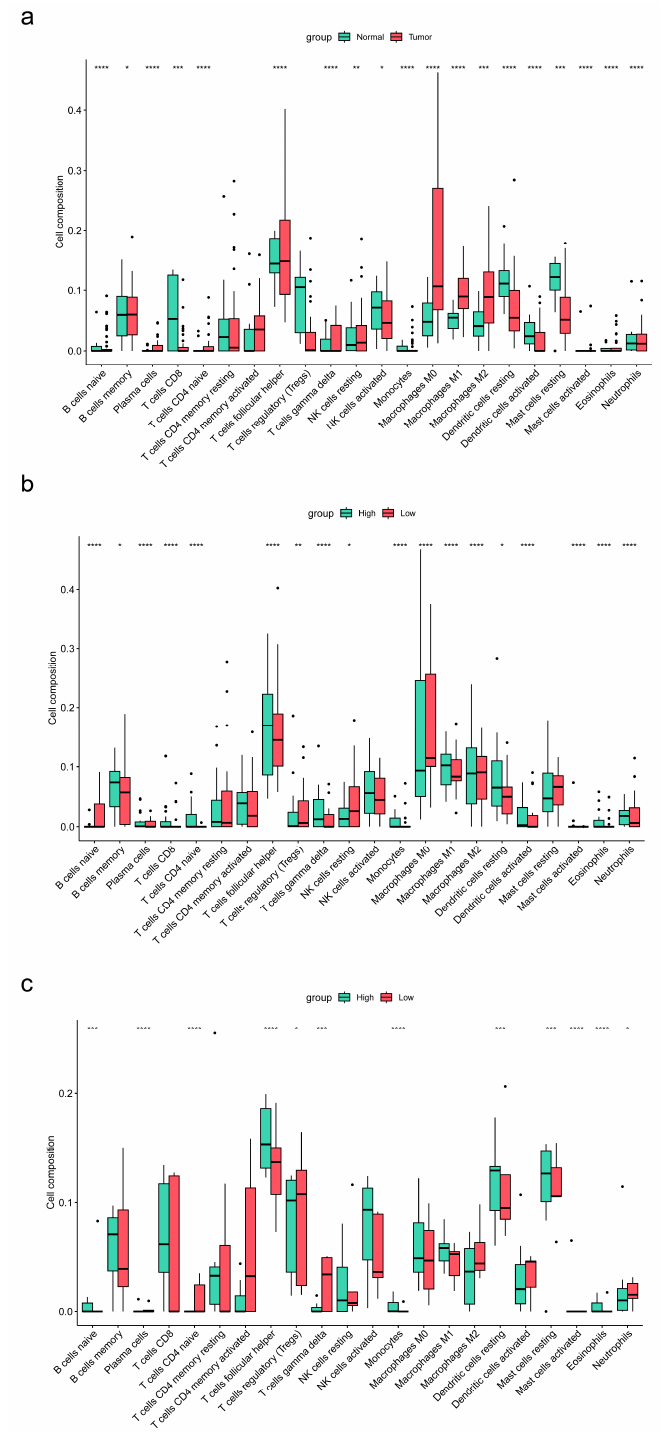
Figure 7. Box plots of the differences in the infiltration abundance of 22 immune cells between ESCC and normal samples and between high and low ENTPD1 -expresing groups. ( a ) Box plot of the differences in the infiltration abundance of 22 immune cells between ESCC and normal samples; ( b ) Box plot of the differences in the infiltration abundance of 22 immune cells between high and low ENTPD1 -expresing groups in ESCC samples; ( c ) Box plot of the differences in the infiltration abundance of 22 immune cells between high and low ENTPD1 -expresing groups in normal samples. ENTPD1 , ectonucleoside triphosphate diphosphohydrolase 1; ESCC, esophageal squamous